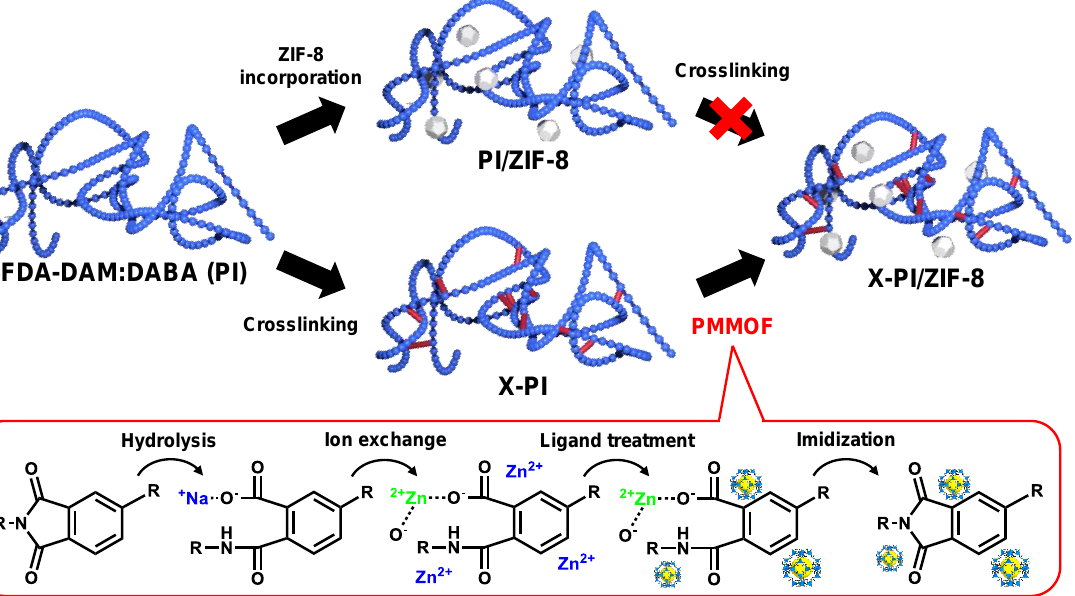
Figure 1. Schematic illustration of preparing cross-linked PI/ZIF-8 MMMs with two different routes: ZIF-8 incorporation either using the conventional blending method or the PMMOF followed by cross-linking (upper arrows) vs. cross-linking followed by PMMOF (see the four-step process in red box) (lower arrows). The red cross on the second upper arrow indicates that thermal cross-linking is not feasible because of the degradation of ZIF-8 fillers at cross-linking temperatures.